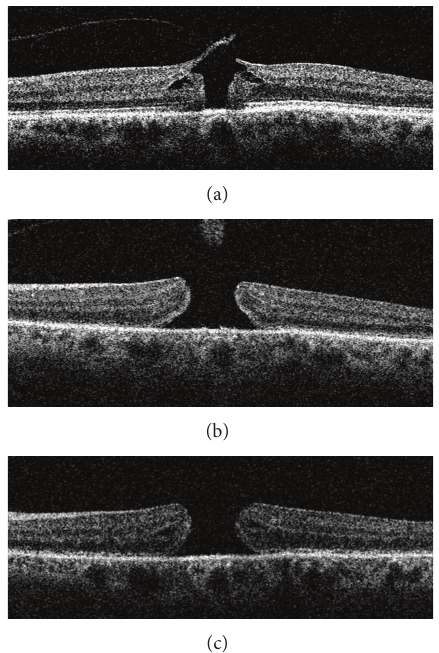
Figure 1: Spectral-domain optical coherence tomography (SD- OCT) 1 day prior (a), 14 days after (b), and 35 days after (c) intravitreal ocriplasmin injection. (a) Prior to ocriplasmin injection, thereisvitreomacularadhesion(VMA),withanunderlyingmacular hole (240 𝜇 m diameter) involving the outer retinal layers. (b) 14 days after ocriplasmin injection, there is a resolution of VMA with enlargementofmacularhole(540 𝜇 mdiameter),whichisnowatfull thickness. (c) 35 days after ocriplasmin injections, the full thickness hole persists (556 𝜇 m